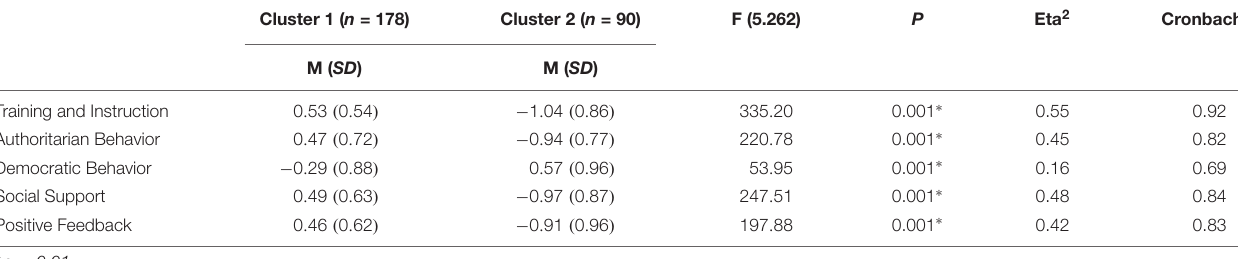
TABLE 1 | Standardized leadership scale scores across the clusters.